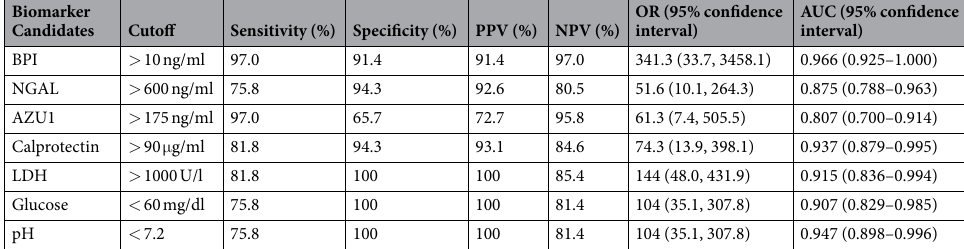
Methods Study subjects and study design.